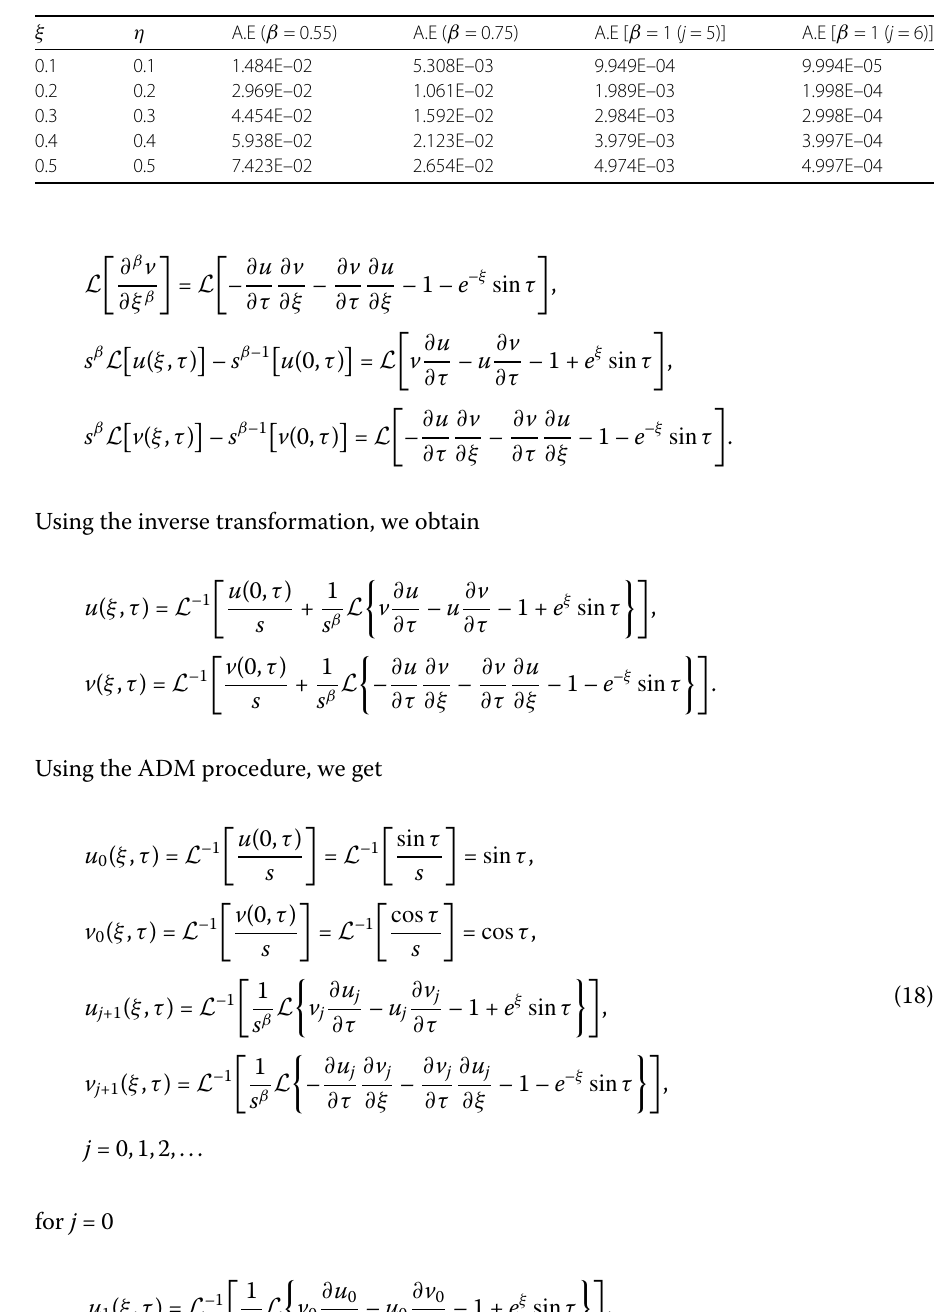
Table 2 LADM solutions of Example 1 at different fractional order β and its corresponding absolute error (A.E) of v at τ =